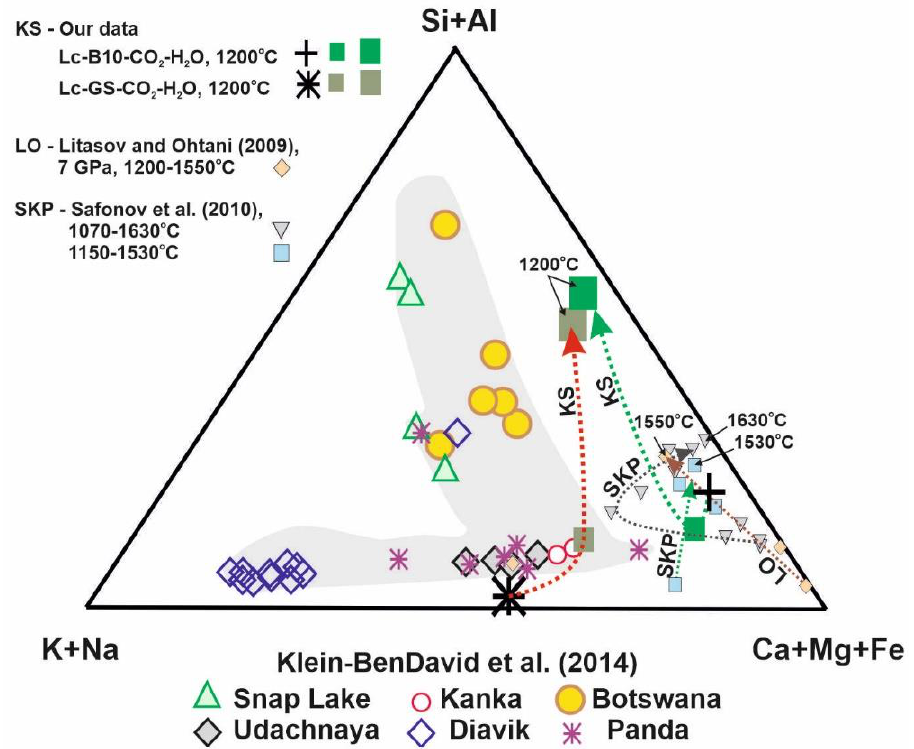
Figure 8. Ternary diagrams of Si + Al − Ca + Mg + Fe − Na + K (mol.%) for the average major element composition of micro-inclusions in diamonds [11] and trends in the evolution of experimentally produced melts in systems: peridotite–carbonate–chloride [15,25], Lc-B10-CO 2 -H 2 O, and Lc-GS-CO 2 -H 2 O (this study).